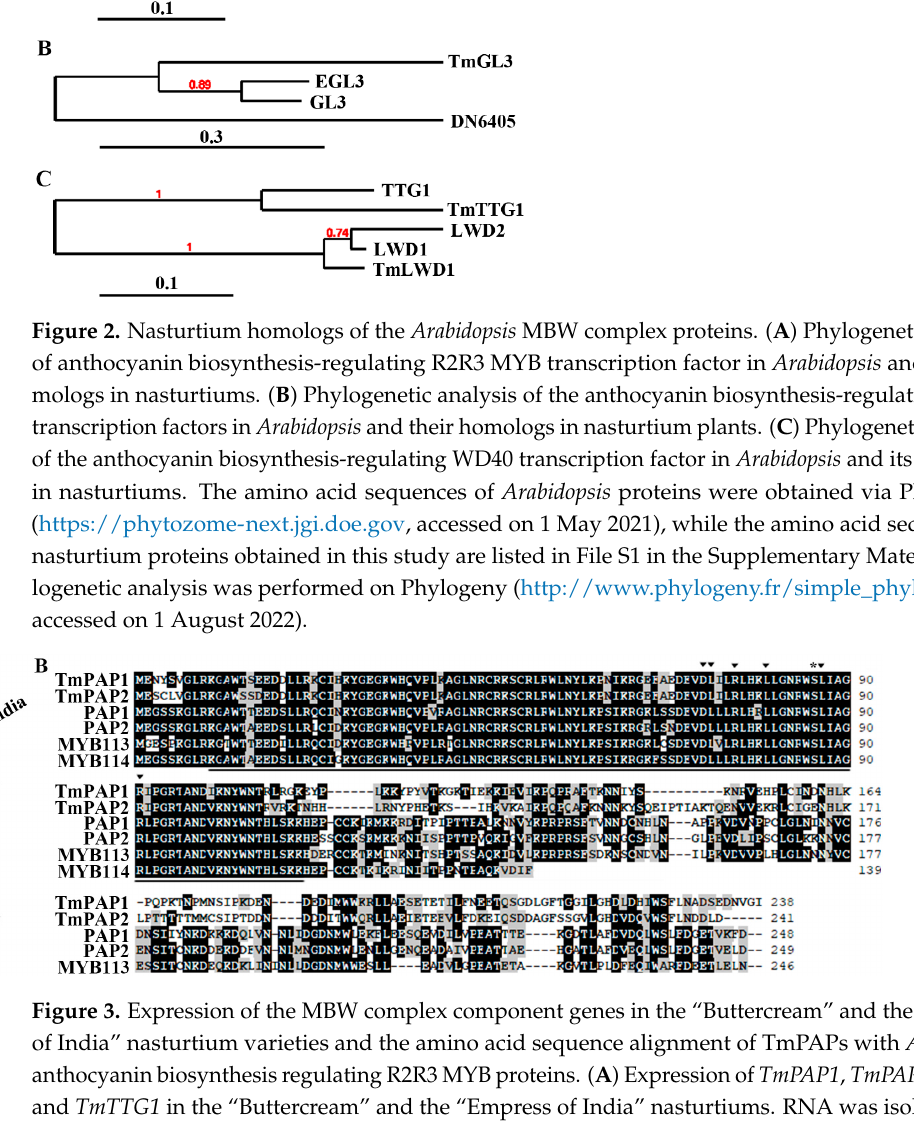
Figure 3. Expression of the MBW complex component genes in the “Buttercream” and the “Empress of India” nasturtium varieties and the amino acid sequence alignment of TmPAPs with Arabidopsis anthocyanin biosynthesis regulating R2R3 MYB proteins. ( A ) Expression of TmPAP1 , TmPAP2 , TmGL3 , and TmTTG1 in the “Buttercream” and the “Empress of India” nasturtiums. RNA was isolated from 7-day-old soil-grown seedlings, and RT-PCR was used to examine the expression of the genes. The expression of TmACT2 was used as a control. ( B ) Amino acid alignment of TmPAPs with Arabidopsis PAP1, PAP2, MYB113, and MYB114. Underlines indicate the R2R3 domain, triangles indicate the amino acid required for the interaction of MYBs with bHLHs, and the star indicates the amino acid critical for DNA binding in